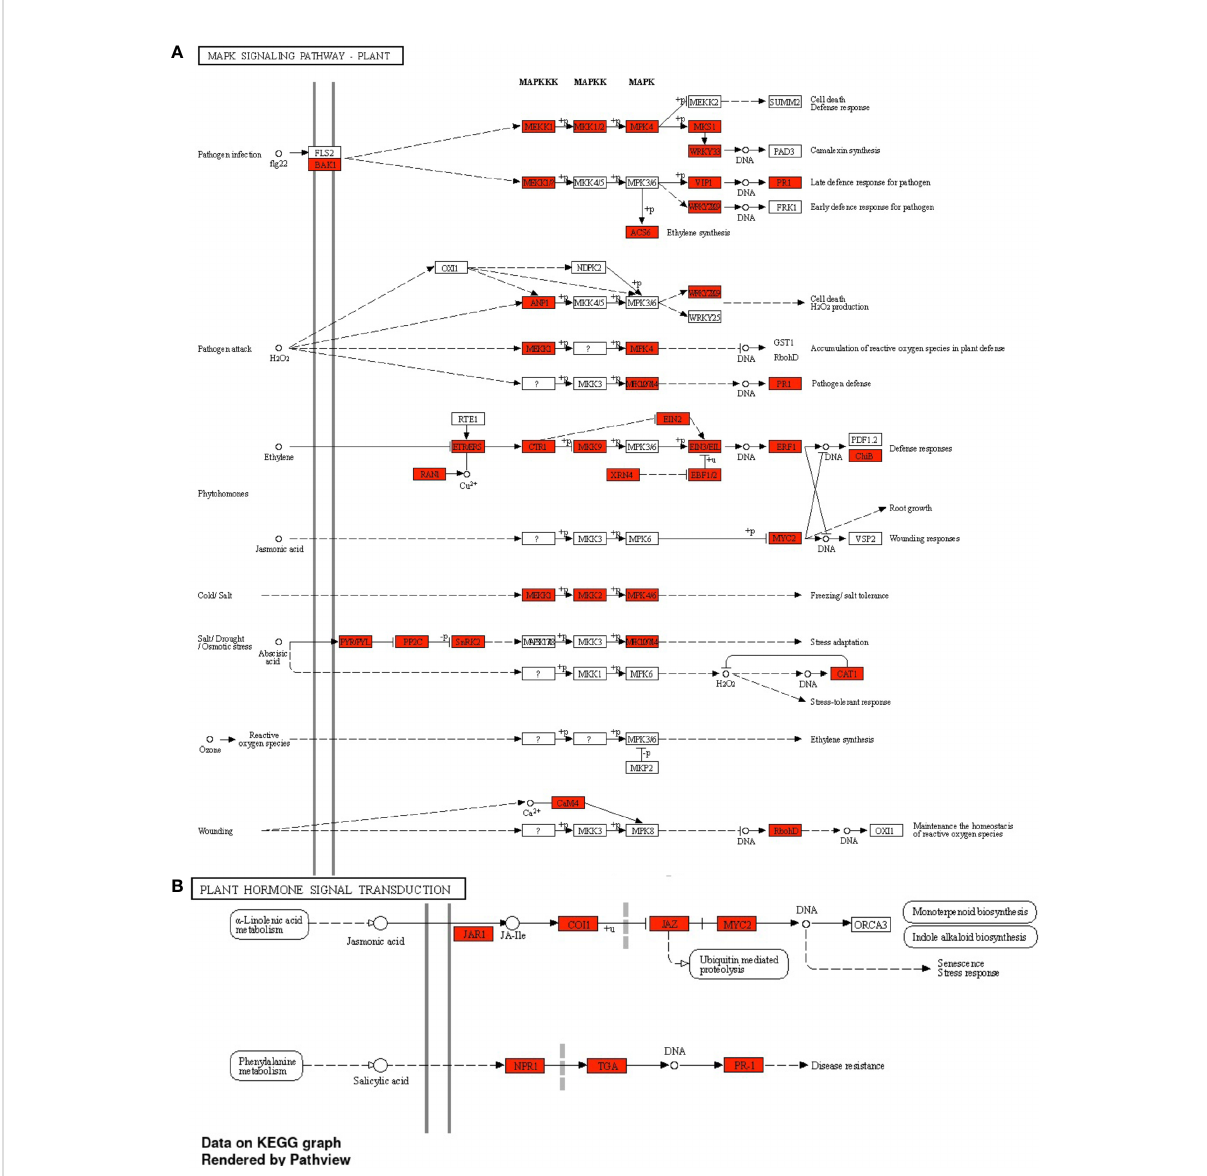
FIGURE 6 MAPK signaling (A) and plant hormone signal transduction (B) pathways in response to fl uopyram in soybean seedling 5 days after planting. KEGG pathway analysis was conducted using ShinyGO (Ge et al., 2020) with a FDR<0.05